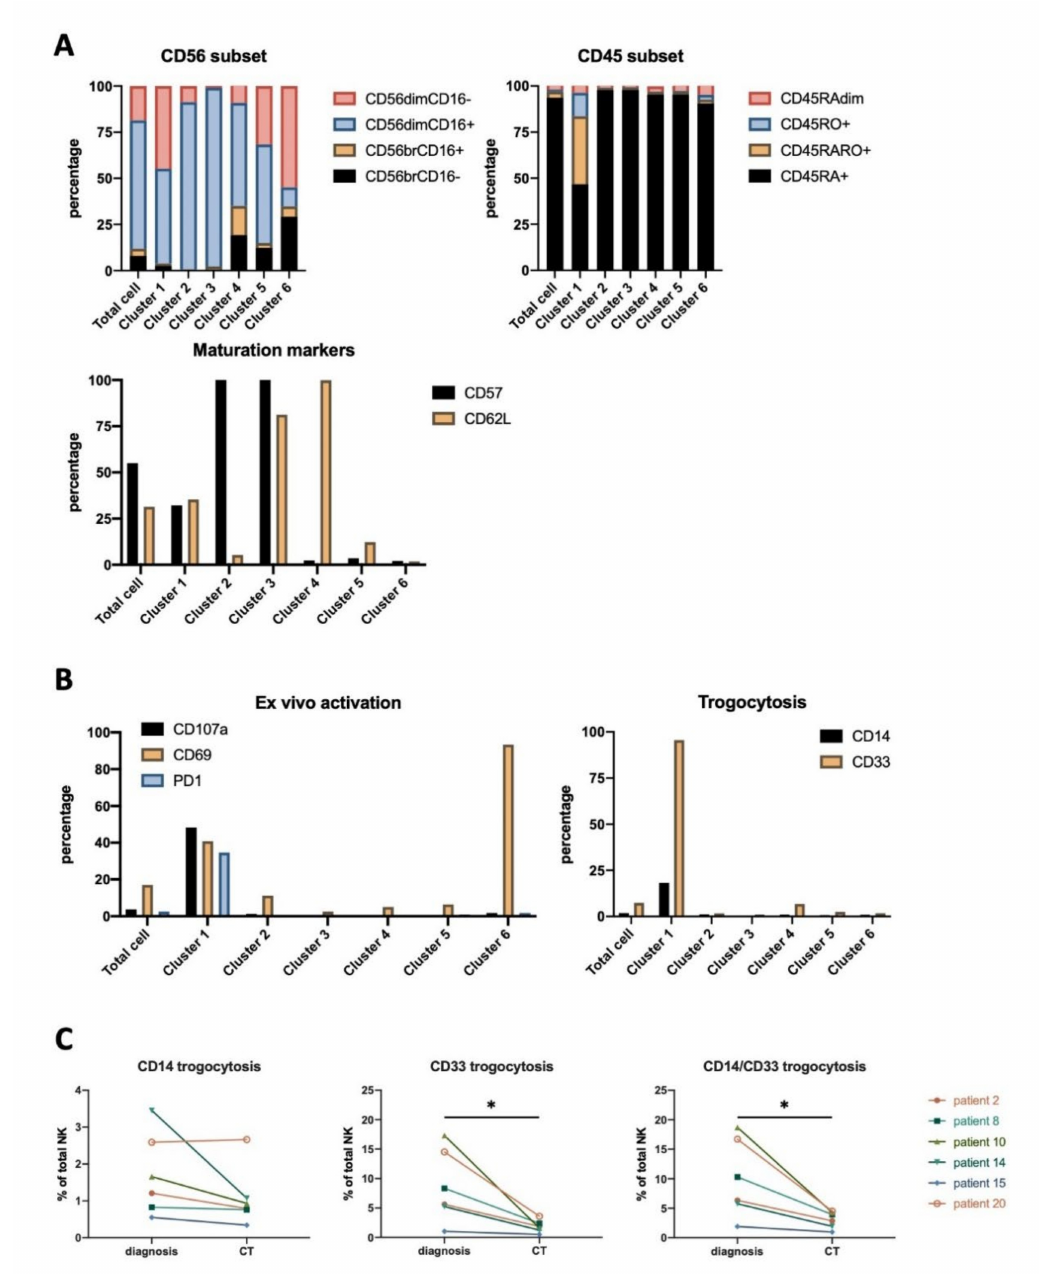
Figure 7. Phenotyping of NK cell clusters identified from UMAP maps in AML patients. Graphs represent for each individual cluster the percentage of the di ff erent NK cell subset. ( A ) Percentage of NK cells that express di ff erent levels of CD56 and CD16 ( left ), CD45RA and CD45RO ( right ), or CD57 and CD62L ( below ). ( B ) Percentage of cells expressing ex vivo CD107a, CD69, PD-1 ( left ) or that have performed trogocytosis on CD33 and CD14 ( right ). ( C ) Percentage of NK cells that performed trogocytosis of myelo-monocyte markers CD14 and / or CD33 at diagnosis and after therapy. * p ≤